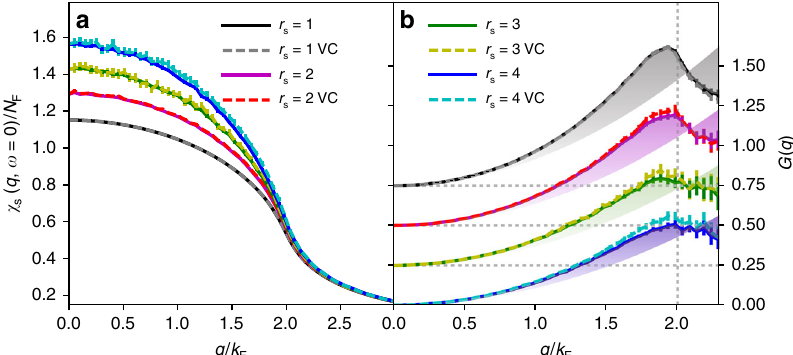
Fig. 3 Spin susceptibility and static local- fi eld correction. a χ s ( q , ω = 0) at optimized λ * for r s = 1 – 4. VC corresponds to VCCFS scheme, and the rest to CFS scheme. The statistical s.d. error bars are displayed for each computed point, and each point is computed statistically independently. In VCCFS scheme the statistical error bars are larger than in CFS scheme, but agree with each other within the error bar. b The local- fi eld correction for the same r s = 1 – 4, and its deviation from quadratic approximation (see the color envelope). For clarity the curves for r s = 1, 2, and 3 are shifted up for 0.75, 0.5, and 0.25